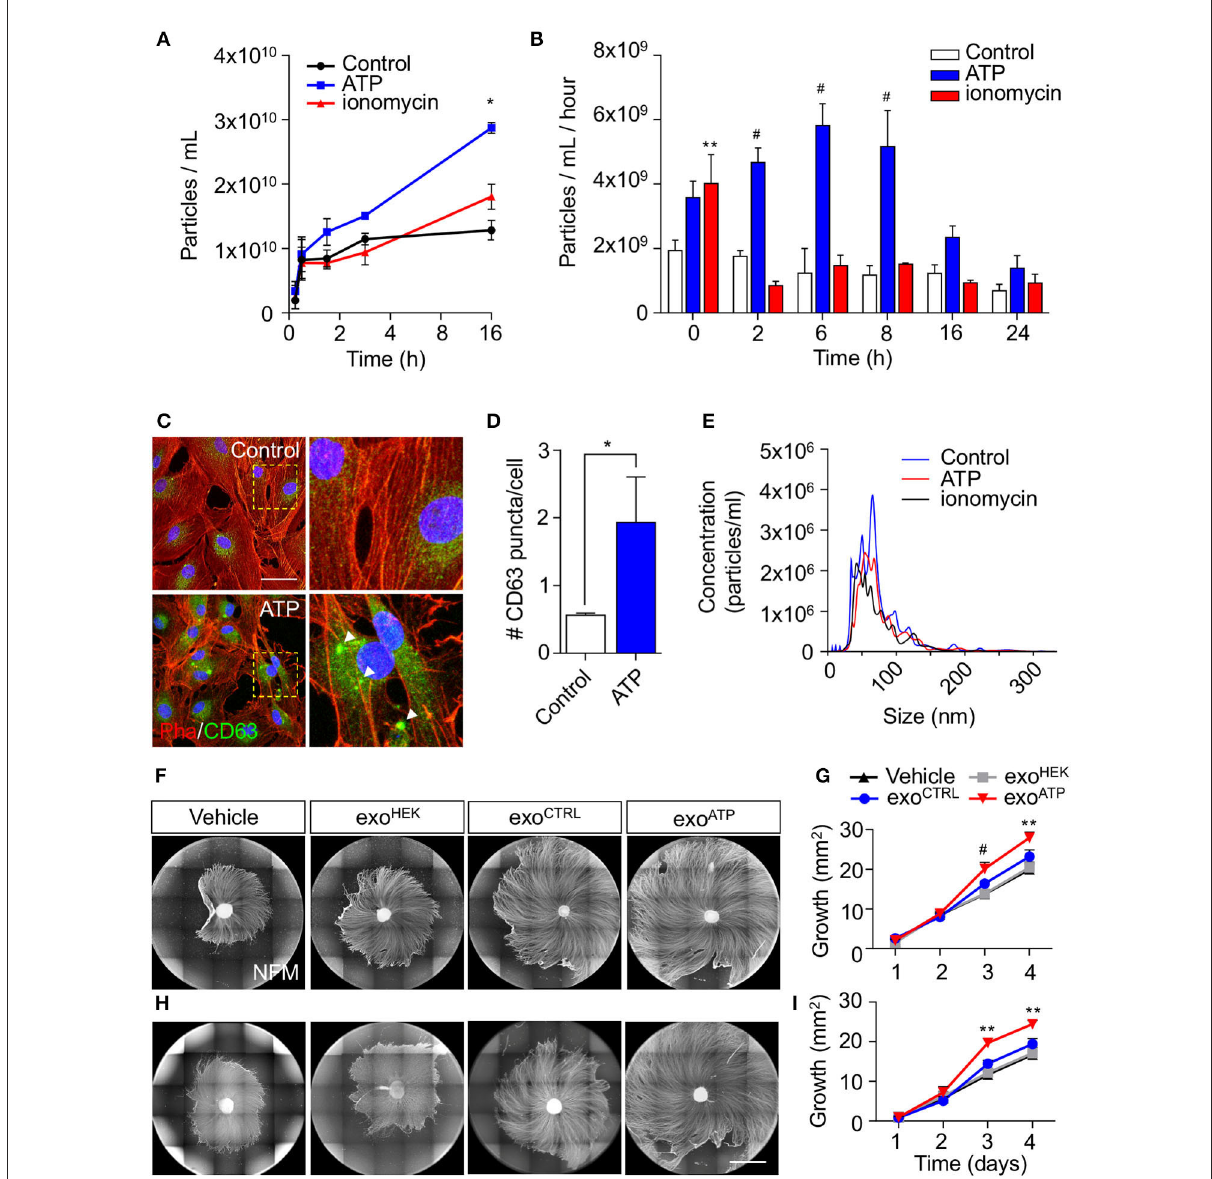
FIGURE2 Effect of ATP in the release of sEVs from rSC and their effect on axonal elongation. The effect of ATP (50 µ M) on rSC sEV was analyzed by nanoparticle tracking analysis (NTA) and immunofluorescence. (A,B) Conditioned media from different time points after ATP treatment were measured by NTA to analyze the accumulation of particles over time and their rate of release by rSC. (C,D) CD63-transduced rSC were quantified for GFP puncta (arrowheads) after ATP treatment. (E) Size distribution of EVs in the different conditions generated by NTA. (F,G) The effect of sEV from rSC treated with or without ATP (50 µ M) on neurons was analyzed by daily treatment of DRG with these sEVs. sEVs from the same volume of conditioned media from rSC stimulated with or without ATP were used to treat DRG daily. (H,I) sEVs normalized by quantity to 0.5 µ g of protein from rSC stimulated with or without ATP were used to treat DRG daily. The elongation effect on DRG was visualized on day 4 by immunofluorescence using neurofilament medium (NFM) immunostaining in axons. Scale bar, 1,500 µ m. In all quantifications, average and SEM of at least three independent experiments are shown ( # p < 0,0001; ** p < 0.001; * p <